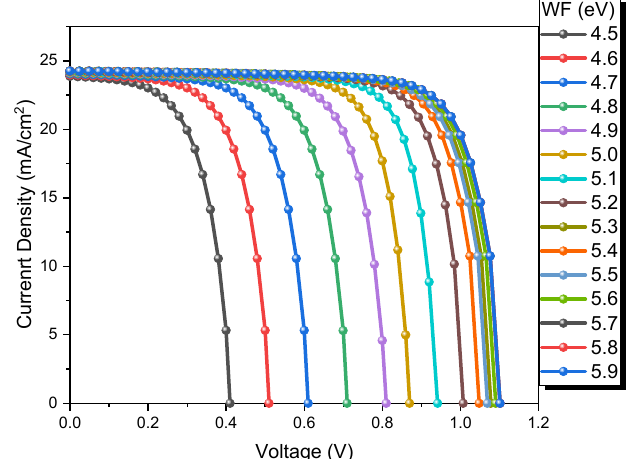
Figure 5. J-V curves of CdTe solar cells at different back work functions.